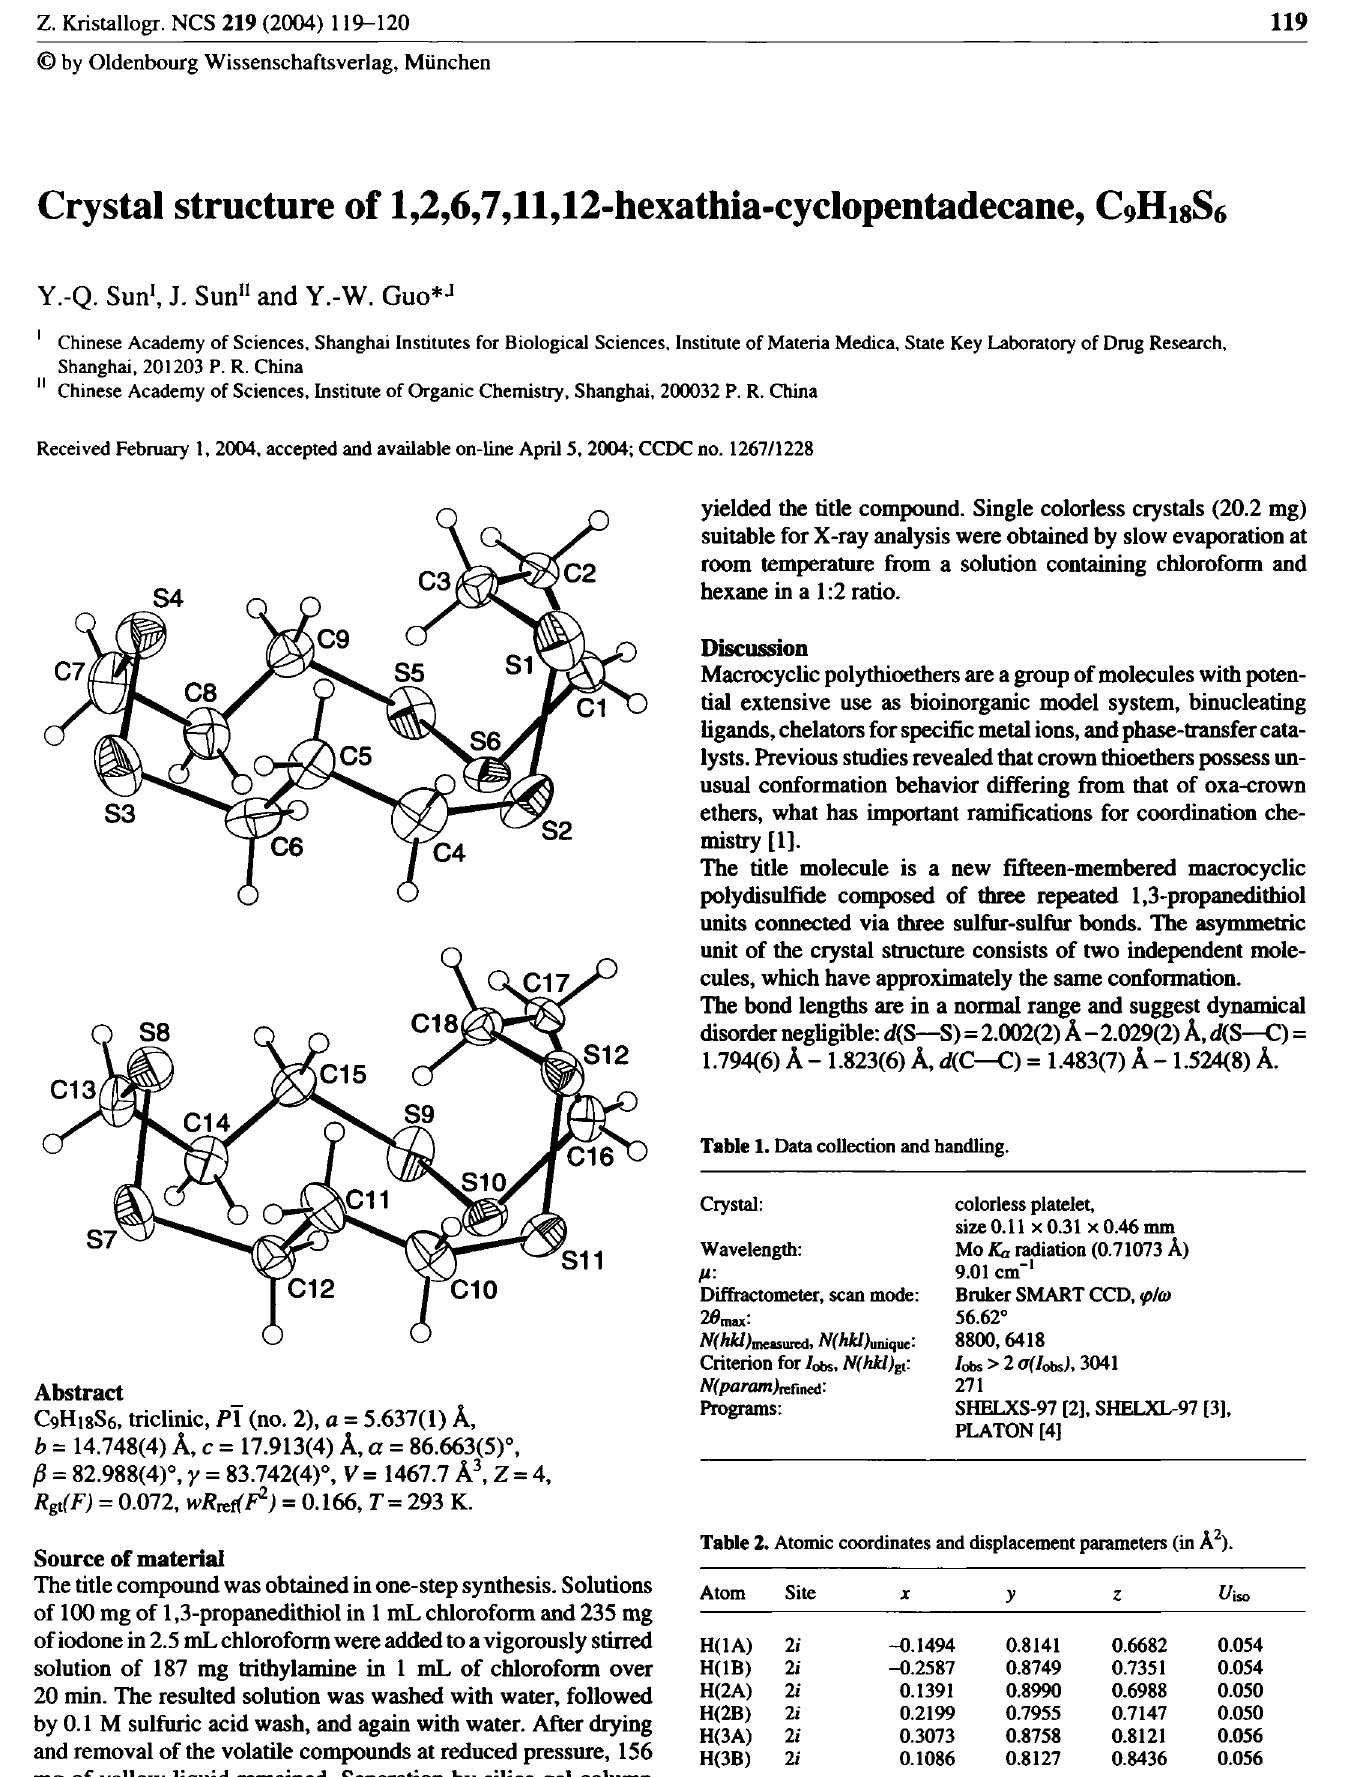
Table 2. Atomic coordinates and displacement parameters (in Â 2